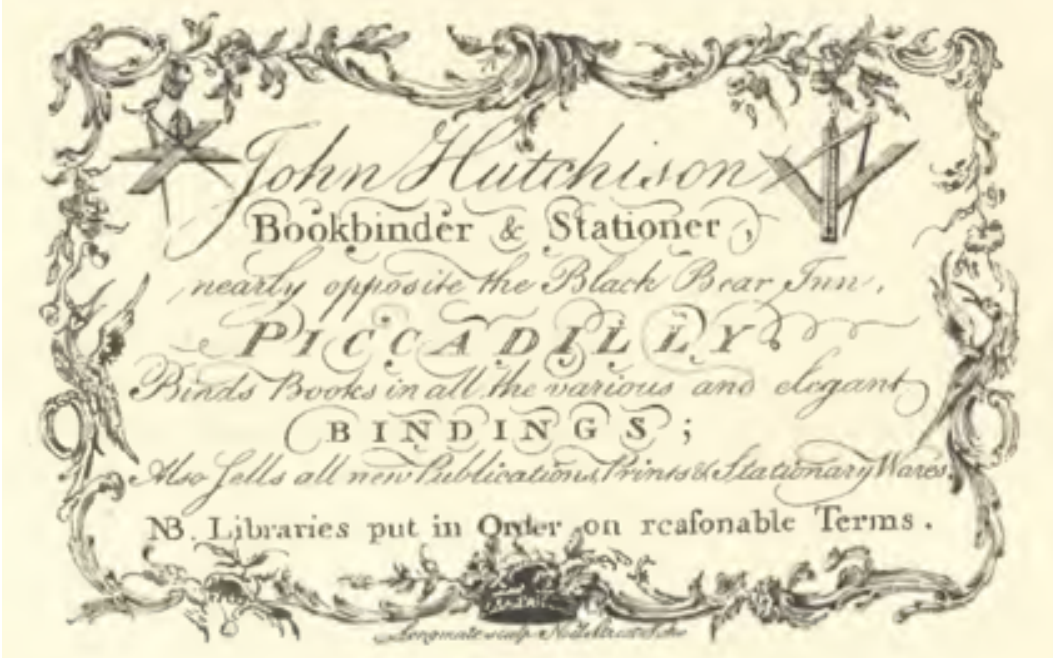
Fig. 7. John Hutchison’s trade ticket with masonic motifs from a book published in 1769.